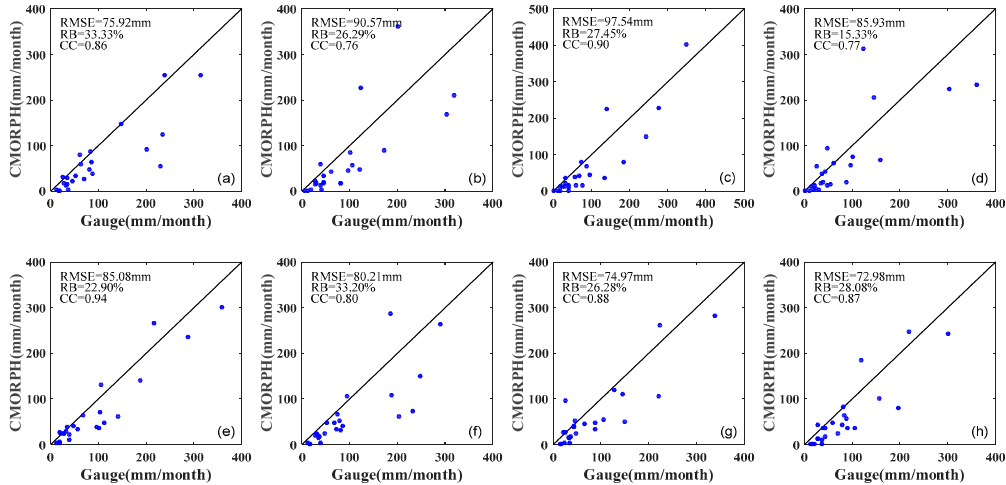
Figure 9. Scatter plots of monthly rainfall from rain gauge data and the CMORPH data (( a – h ) indicate that the gauge ID in Table 1).